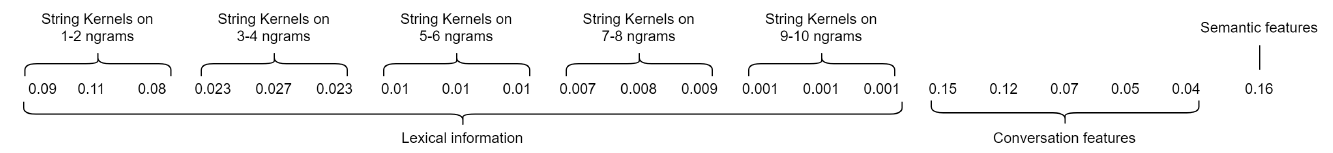
Figure 3. Gini feature importance for random forest with string kernels.